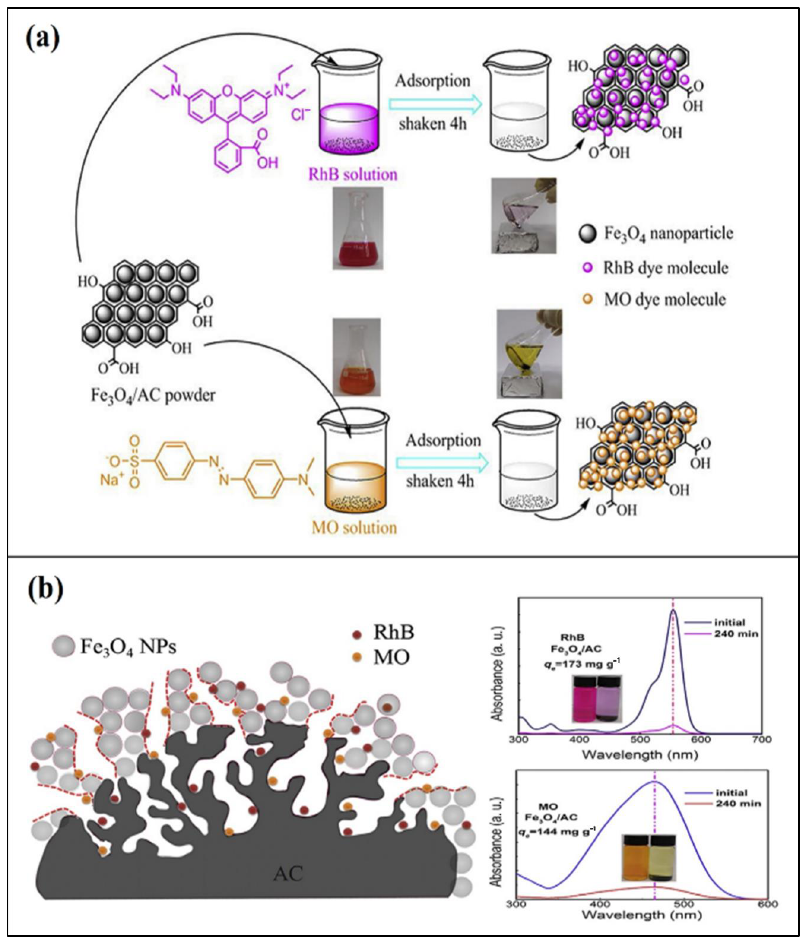
Figure 7. Schematic drawing of using magnetic activated carbon in dye removal; ( a ) the application of Fe 3 O 4 /AC sample for removing rhodamine B and methyl orange from the aqueous solution, and ( b ) the adsorption mechanism. Reprinted with permission from Ref. [100], 2019, Elsevier.